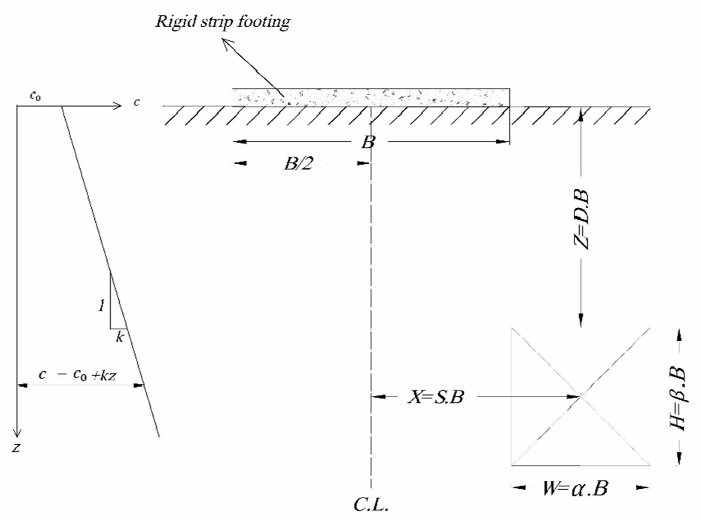
Figure 1. Problem geometry and notation.